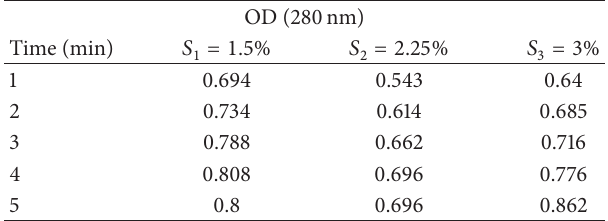
Table1:Substrateconcentrationsforcalculatingkineticparameters.